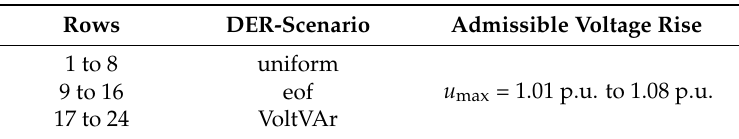
Table 3. Investigated scenarios.